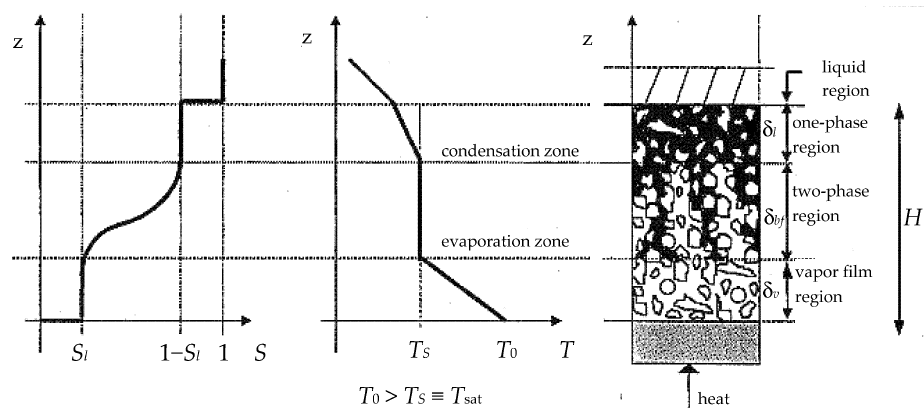
Figure 1. Evaporation in a porous media limited by an overlying water-free surface due to the heat addition from below at temperatures above the saturation.